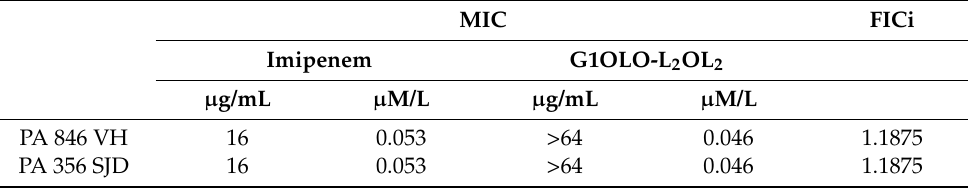
Table 5. MIC and FICi data from the synergy study of G1OLO-L 2 OL 2 and imipenem. MIC